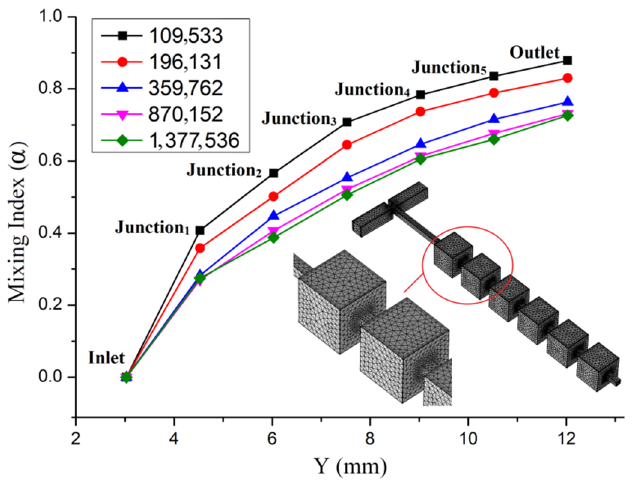
Figure 2. Mesh independence analysis for the mixing indexes along the direction of flow (Y-axis) and the mesh used in the current